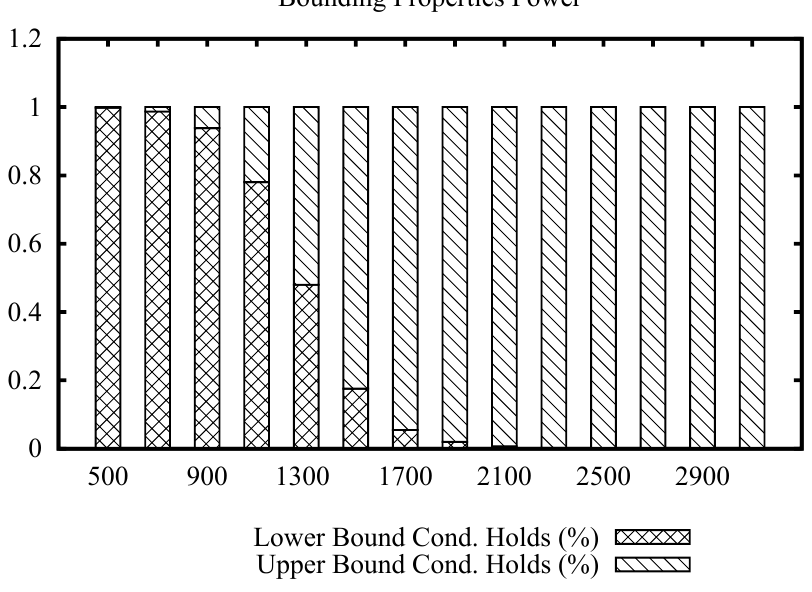
Figure 4. Percentage of filtering that each bounding property can achieve within the range of radius of the join algorithm using the ImgTexture data